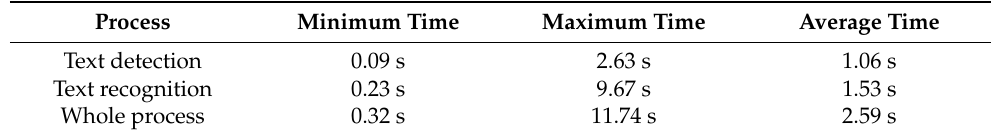
Table 5. The time cost of user behavior